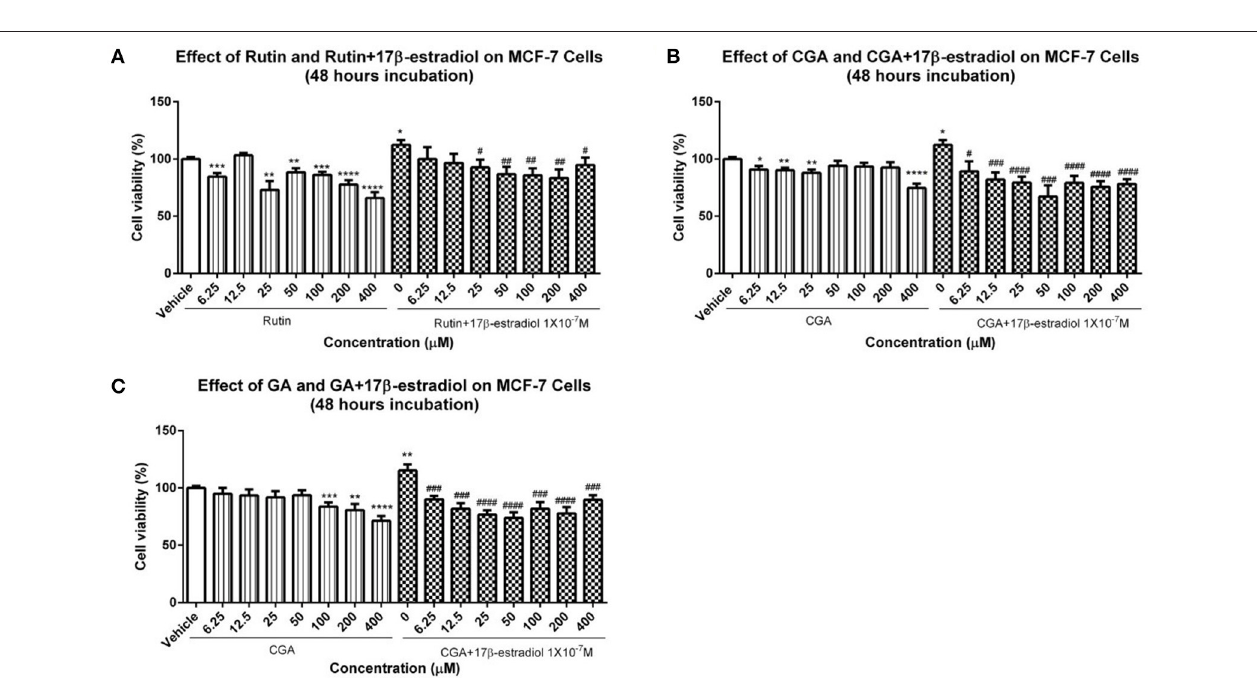
FIGURE 12 | Effects of rutin, CGA, and GA on estrogen receptor expression in ovarian granulosa cells after treatment for 12h. Ovarian granulosa cells of SD rats were treated with various concentrations of rutin, CGA, and GA for 12h, respectively, and then total cell lysates were extracted for Western blot analysis by using antibodies specific to ER α and ER β . The representative image and the relative expression levels analyzed of (A) ER α and (B) ER β are shown. The loading control of ER β is reused from that of StAR since they were from the same membrane. The data were normalized with the internal control β -actin, and each value is the mean ± SEM ( n = 4), with * p < 0.05, ** p < 0.01, *** p < 0.001, vs. vehicle control group.